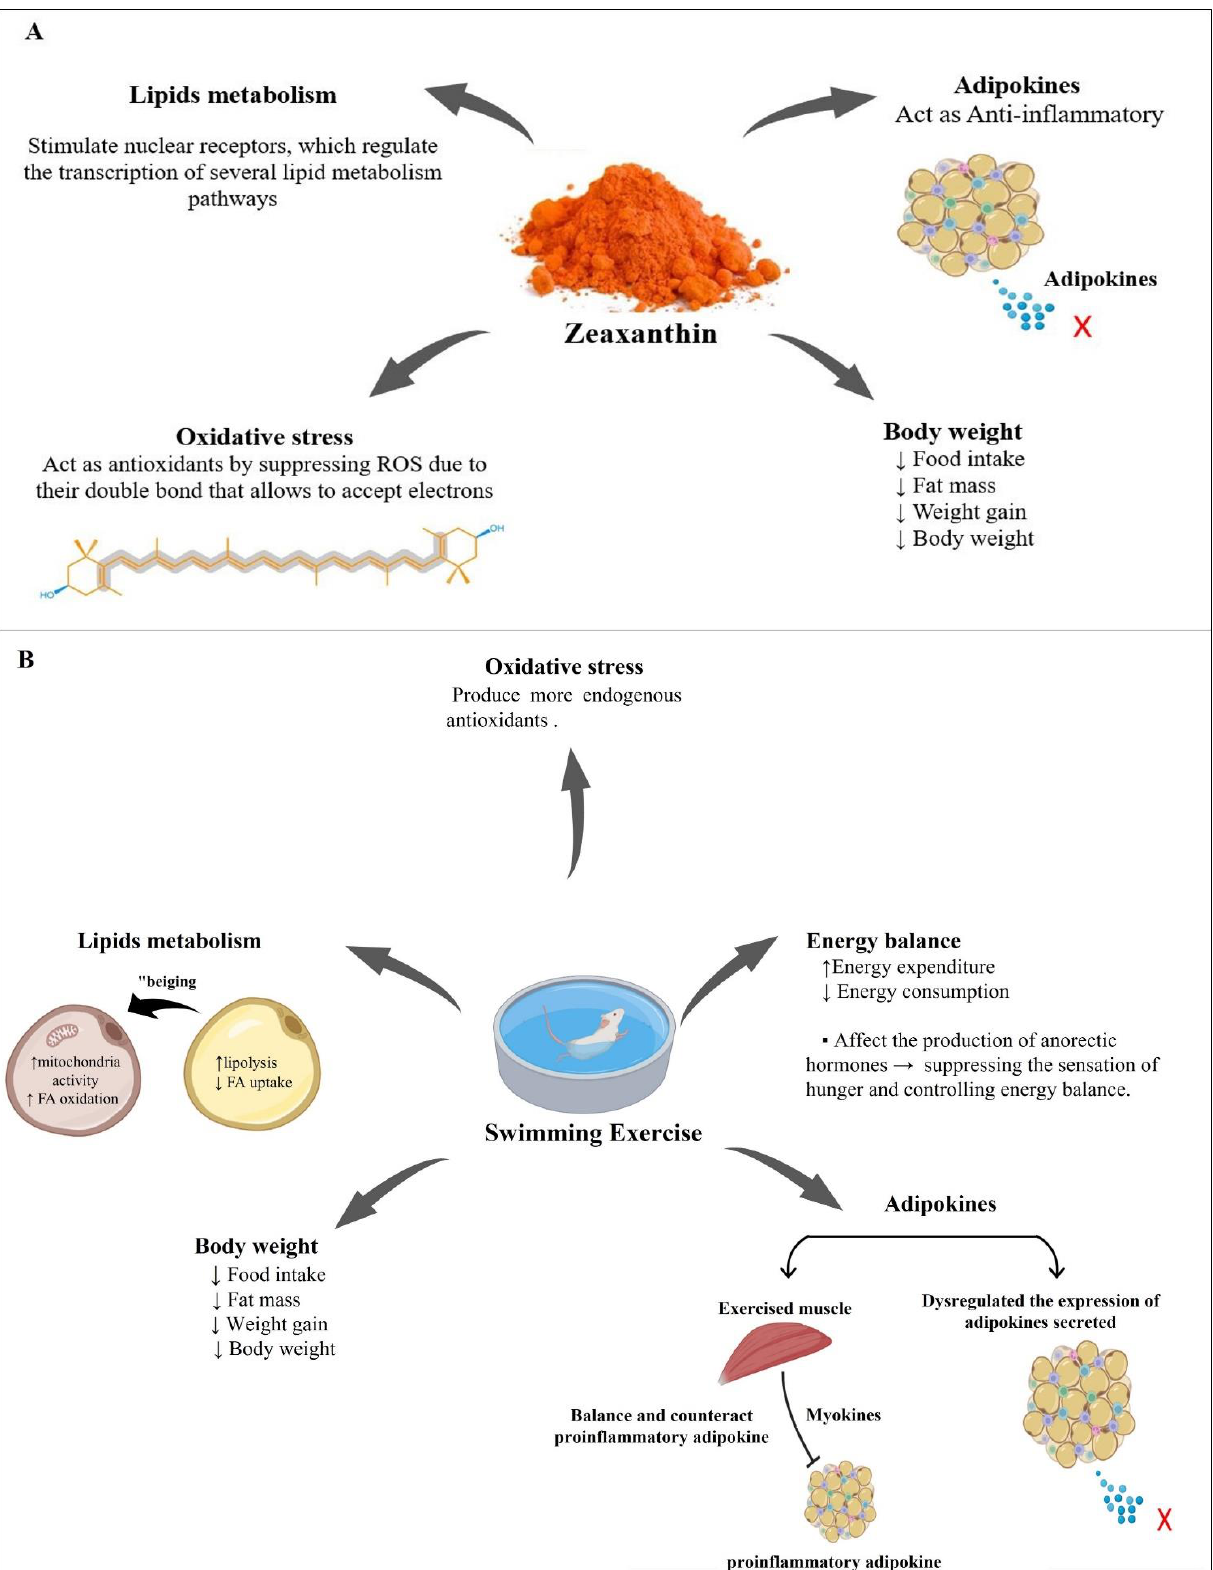
Figure 8. Possible mechanisms of zeaxanthin ( A ) and exercise ( B ) leading to the reduction of the complications of obesity and contributing to its treatment. ↑ =increase, ↓ = decrease, x =no adipokine secreted.